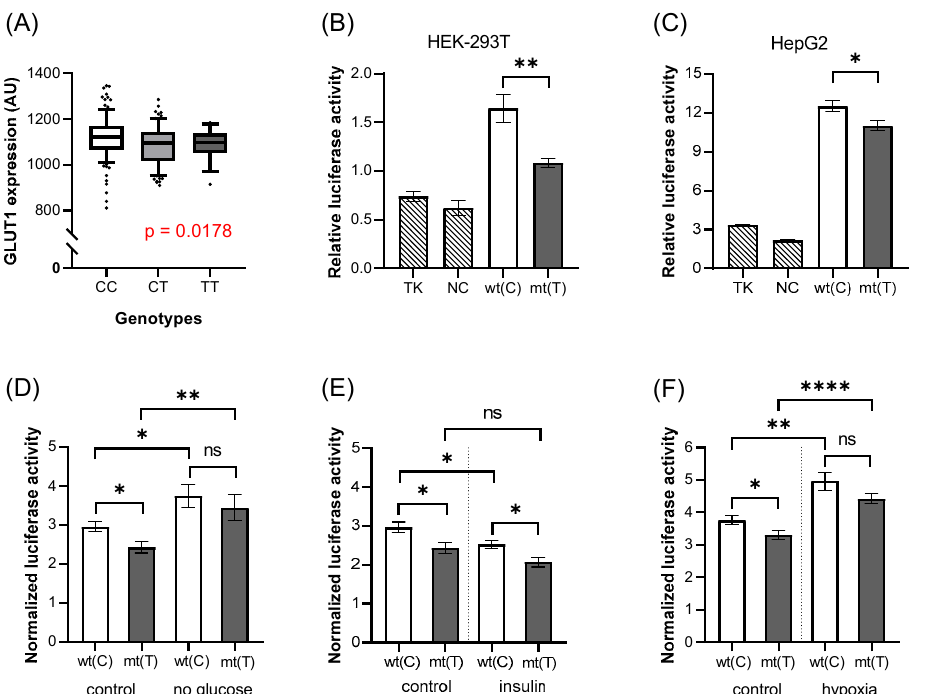
Figure 3. The effects of rs841847 on GLUT1 expression and luciferase activity. The association between the expression of the GLUT1 membrane protein and the genotypes of the variant ( A ). Each boxplot represents samples with different genotypes, in the range of 10–90 percentile, while dots represent samples out of range. This insert has increased luciferase activity in HEK-293T ( B ) and HepG2 ( C – F ) cells, compared to the empty vector. Mutant allele decreases this enhancer effect in both cell lines. Treatments influence the luciferase activity regardless of the alleles. The p ‐ values of the luciferase experiments ( B – F ) were calculated using the Welch t ‐ test. The stars represent significance at different levels: * p < 0.05, ** p < 0.01, **** p < 0.0001. In the case of the treatments, data were normalized to the results of the “empty” vector. wt(C): wild ‐ type allele; mt(T): mutant allele; TK: “empty” vector without insert; NC: negative control (random sequence); ns: not significant; AU: arbitrary unit.